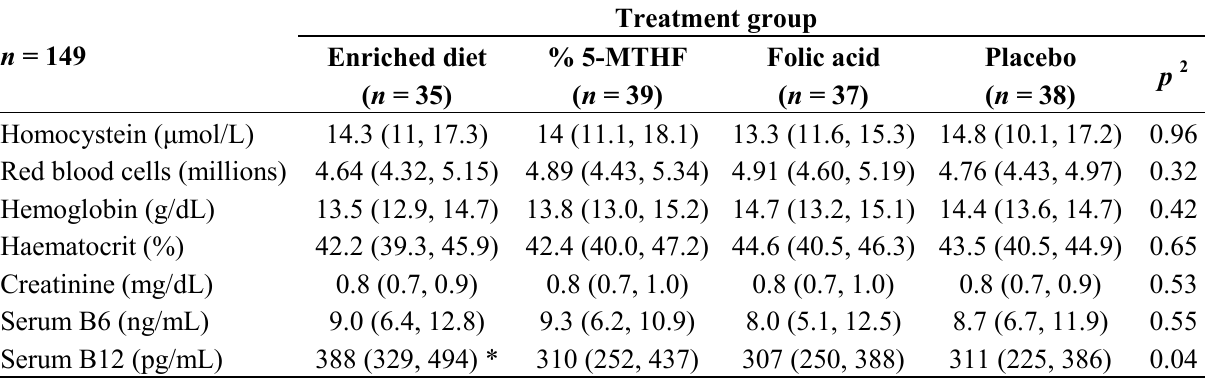
Table 2. Baseline blood biomarkers of the participants according to treatment group 1